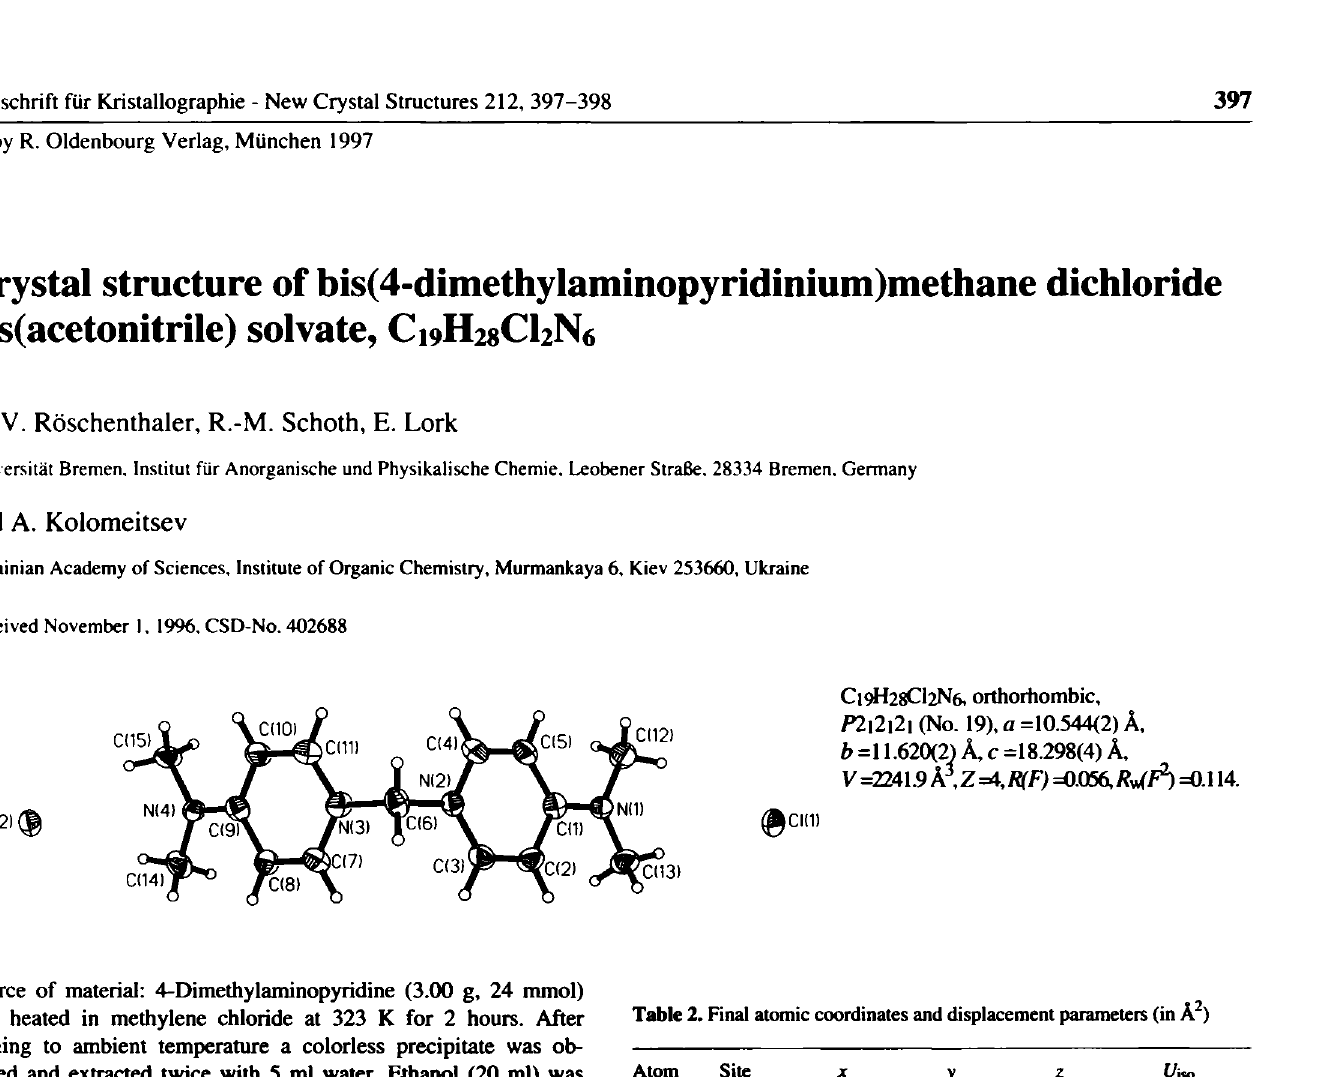
Table 1. Parameters used for the X-ray data collection Crystal: